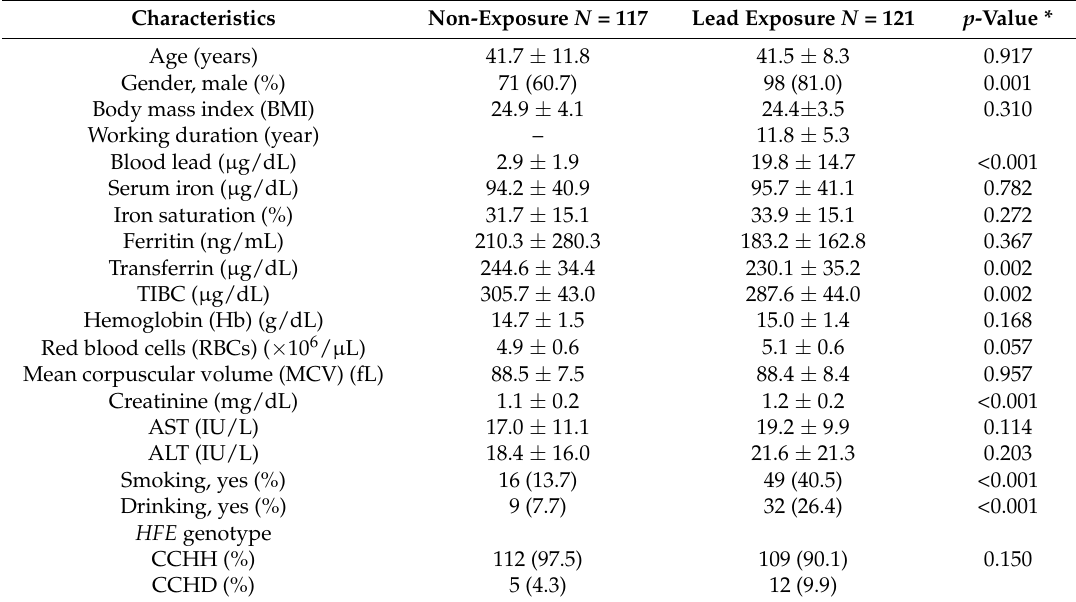
Table 1. Comparison between the unexposed group and the lead-exposed group.